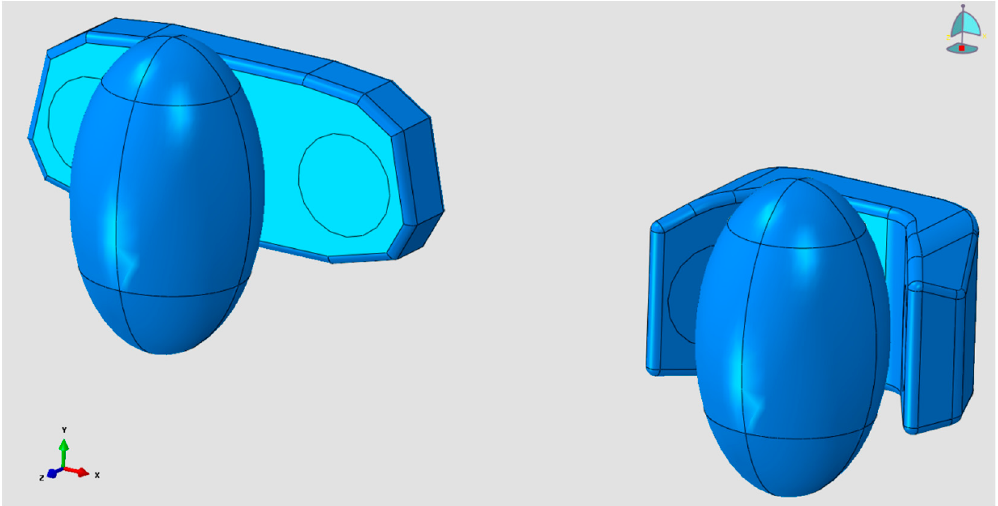
Figure 8. CAD models for the head and the folded and unfolded configurations.